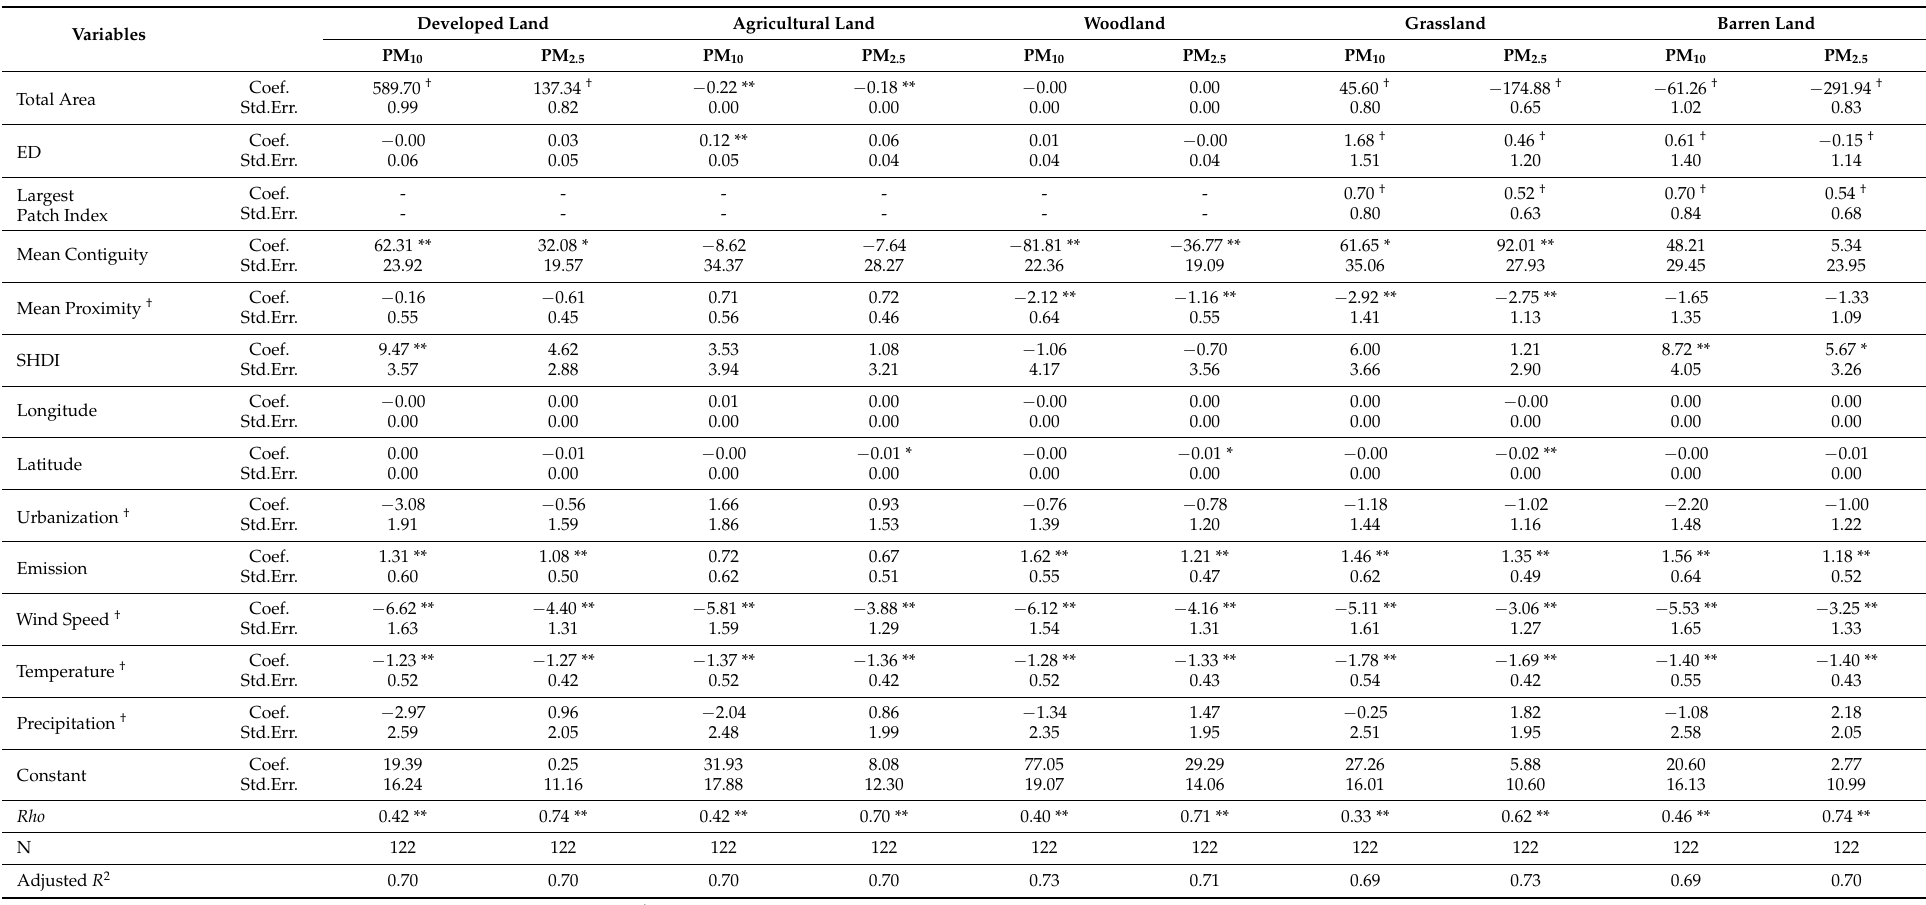
Table 3. Results of the